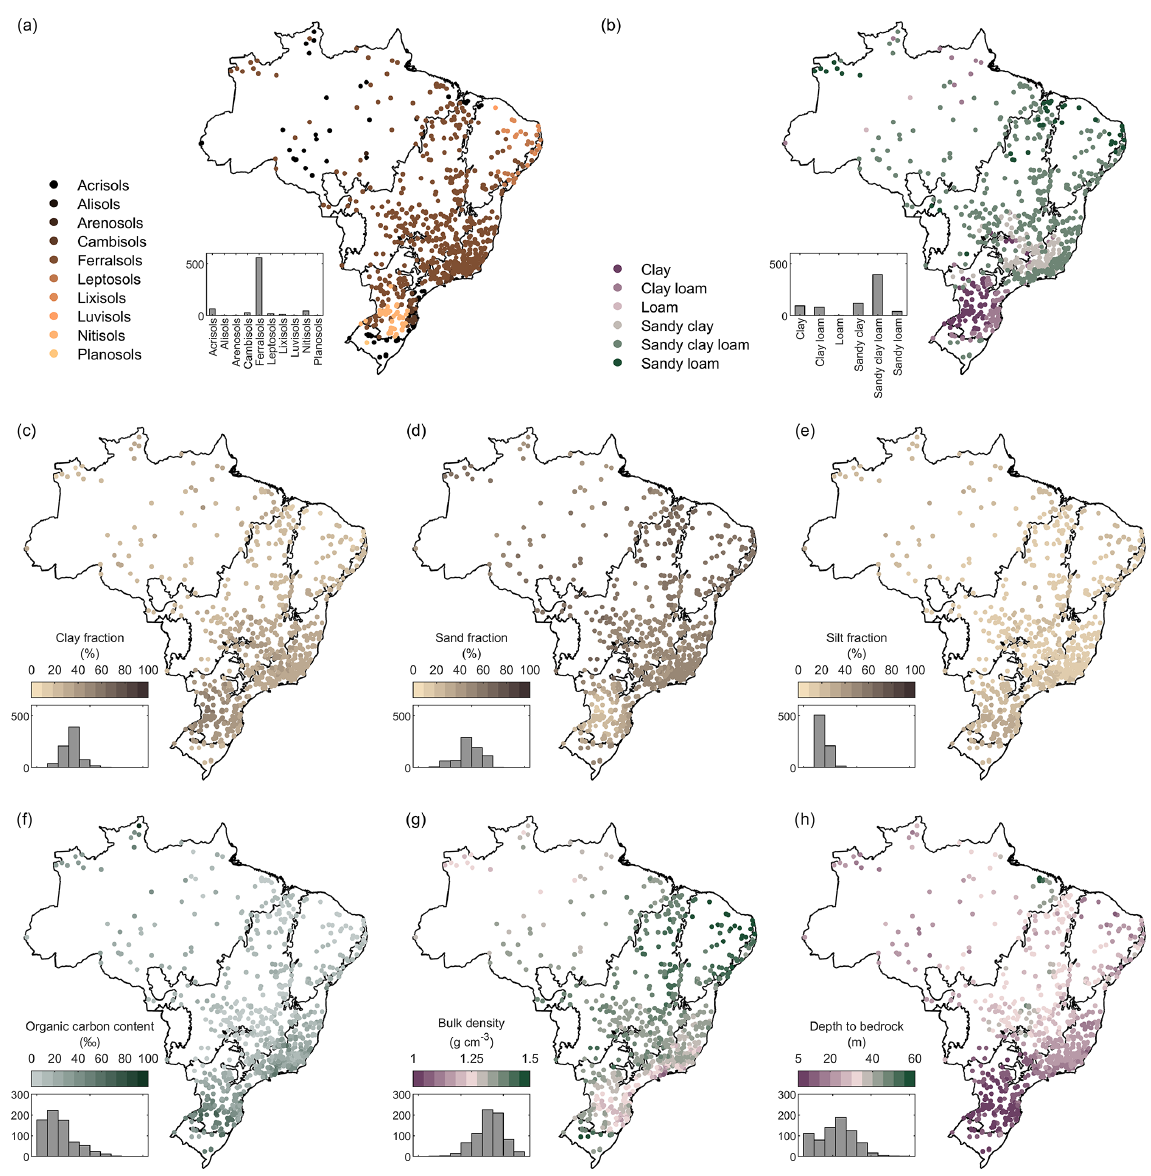
Figure 9. Spatial distribution of the soil attributes of the CABra catchments. (a) The most common type of soil in the catchment; (b) the class of texture based on USDA classification; (c) the clay fraction of the soil (in percent); (d) the sand fraction of the soil (in percent); (e) the silt fraction of the soil (in percent); (f) the organic carbon content of the soil (in per mill); (g) the bulk density of the soil (in gcm − 3 ); (h) the depth to soil bedrock (in m). Table 7. Geological attributes of CABra